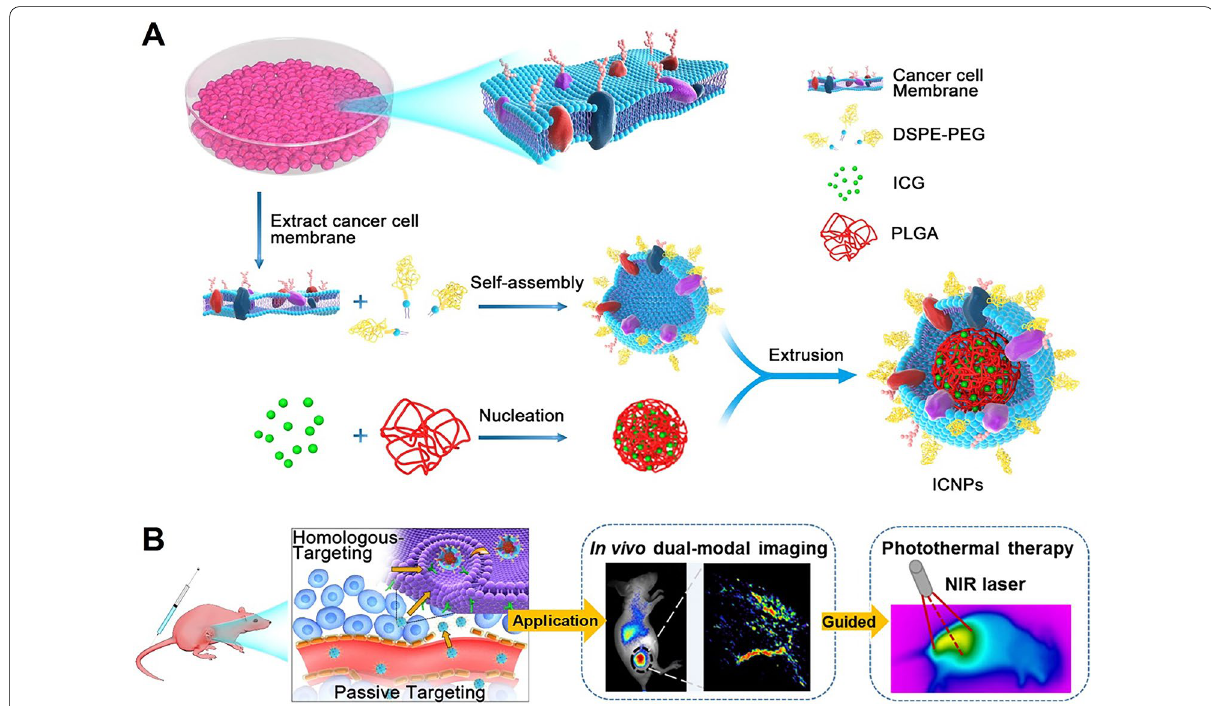
Fig. 4 Illustration of the cancer cell membrane–biomimetic NPs for targeting recognition of source cancer cell, dual-modal imaging, and photothermal therapy. ( A ) Preparation procedure of ICNPs. Extracting cancer MCF-7 cell membrane hybridized with PEGylated phospholipids (DSPE-PEG) and then coated onto ICG-loaded polymeric cores by extrusion. ( B ) Schematic of homologous targeting ICNPs for dual-modal imaging guided photothermal therapy. Through specific homologous targeting and the EPR effect (passive targeting), ICNPs realized perfect tumor accumulation, dual-modal FL/PA imaging, and effective photothermal therapy after intravenous injection. Reprinted with permission from Ref.